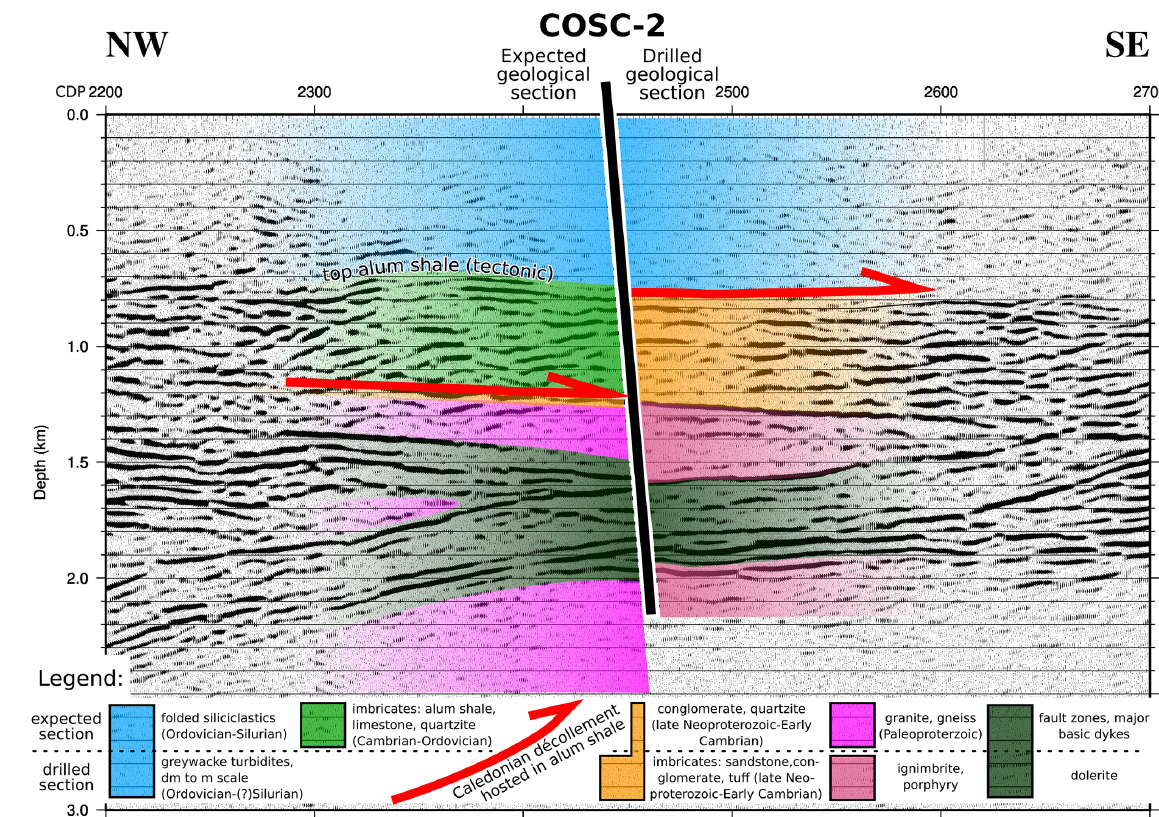
Figure 2. The COSC-2 expected geology (left) and the drilled geology (right) superimposed on the depth-converted seismic section that represents the rock in the vicinity of the COSC-2 drill site. See Fig. 1 for the location and note that, due to reprocessing, CDP points are shifted when compared with the original publications (Hedin et al., 2012; Juhlin et al.,